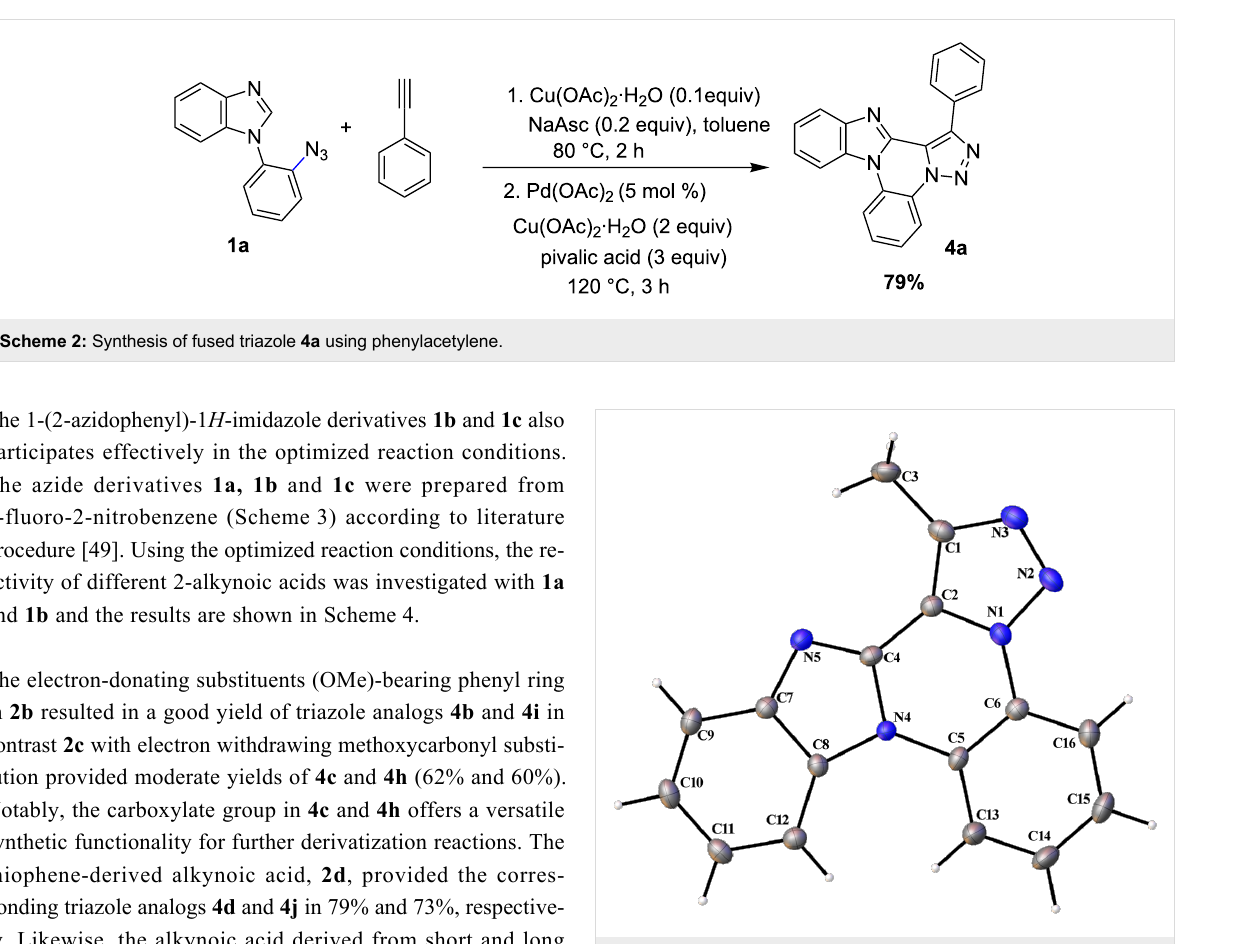
Figure 1: ORTEP diagram of 4f (CCDC